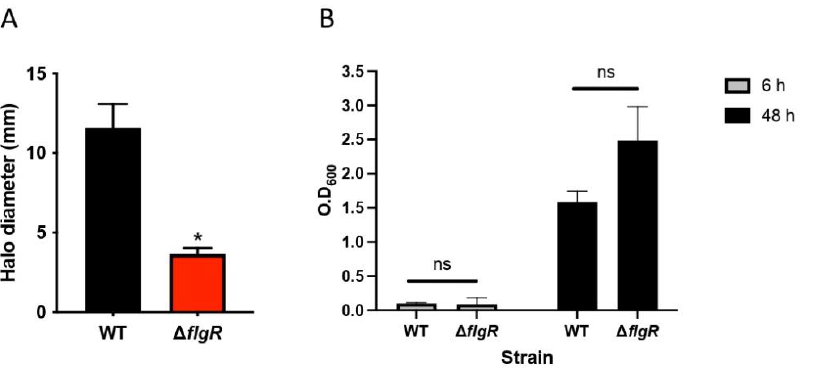
Figure 3. The motility phenotypes of wild-type H. pylori and the ∆ flgR mutant. ( A ) The motility of H. pylori and mutant strains in semisolid Brucella motility agar. Bacteria were inoculated into Brucella motility agar and incubated at 37 ◦ C under microaerobic conditions for 5 days. The growth halo diameters were measured and are presented as the mean ± SD from measurements of five independent experiments, * p < 0.05, ns: non-significant. ( B ) Growth of H. pylori and the ∆ flgR mutant in medium BB10 over time was measured by OD 600nm at 6 h and 48 h of incubation. Data are represented as the mean ± standard deviation from three independent